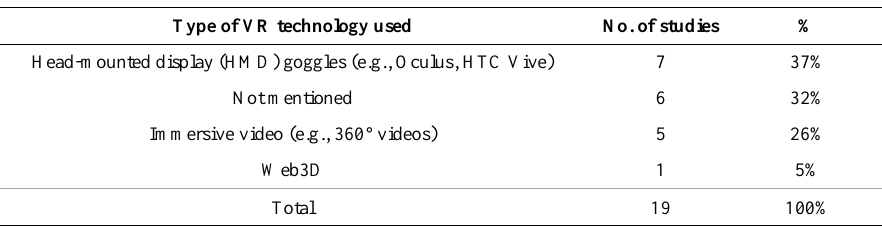
Table 4. Types of virtual reality technology used in the articles